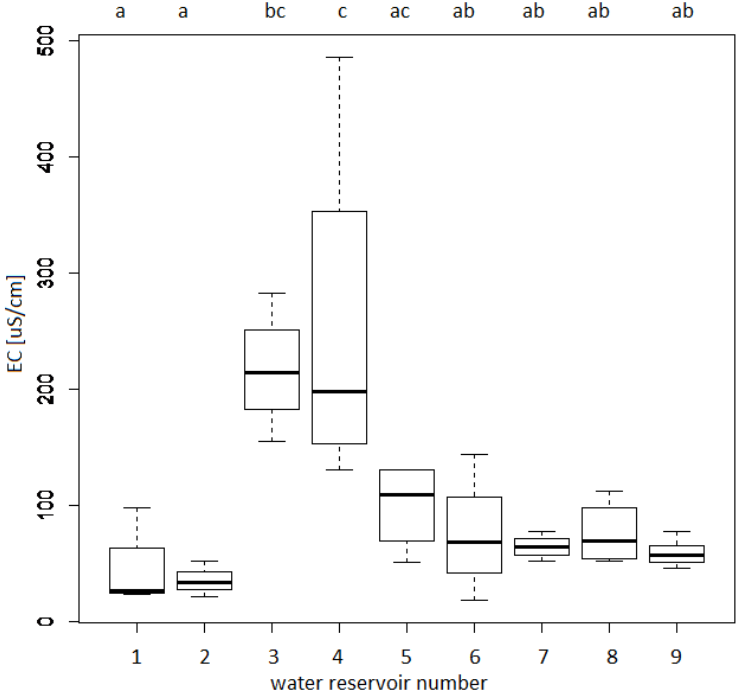
Figure 7. Electrical conductivity of the water in the examined reservoirs (different letters demonstrate significant differences at p < 0.01).